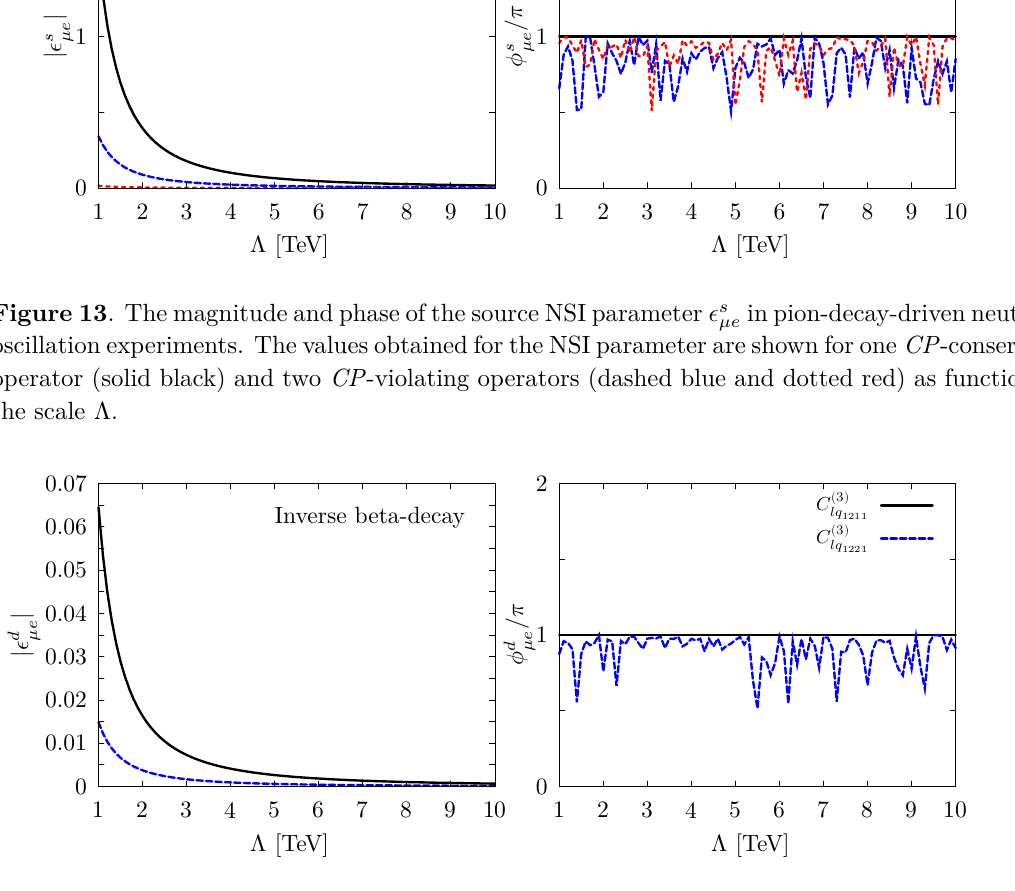
in reactor experiments, µe